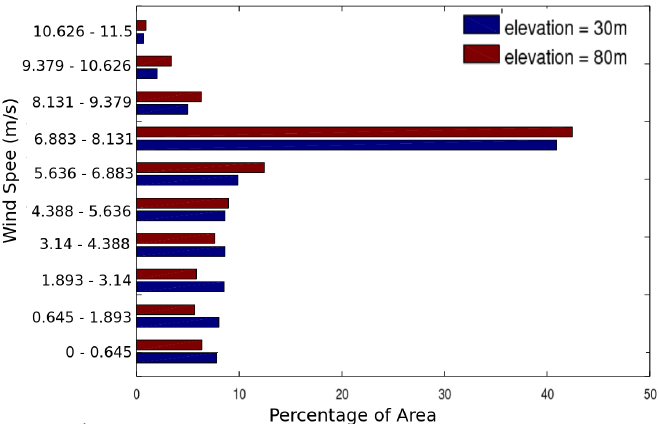
Figure 17. Velocity magnitude at 80 m.